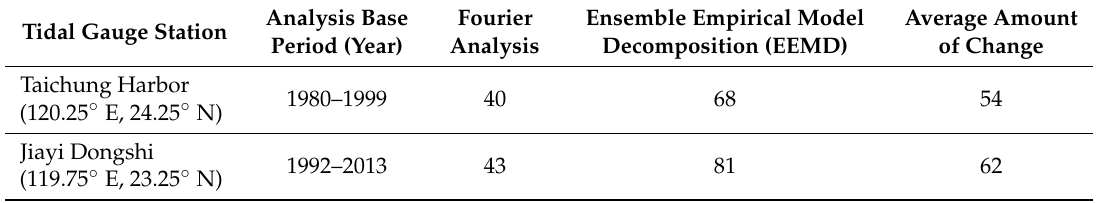
Table 5. Estimation of average sea level rise in the mid-western coast of